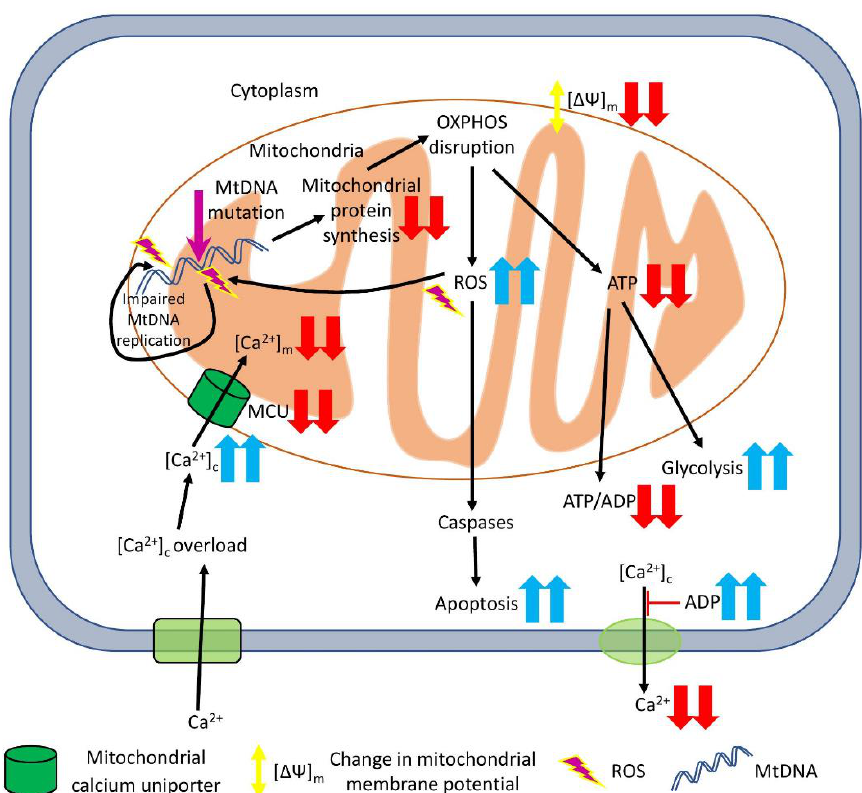
Figure 1. Potential pathways affected by mtDNA mutations and associated with CVD. The mtDNA mutations lead to a decreased level of tRNAs and protein synthesis (including proteins involved in mitochondrial OXPHOS), and increased ROS production and, subsequently, mitochondrial oxidative stress and cell apoptosis. High ROS levels tend to cause more mutations in mtDNA during its replication. OXPHOS malfunction leads to lower ATP output and the collapse of the mitochondrial membrane potential, thus changing the ATP/ADP ratio, interrupting normal ion traffic and stimulating glycolysis as an alternative ATP-generation pathway. An impaired Ca 2+ metabolism can cause the accumulation of Ca 2+ in the cytosol, with low concentrations in mitochondria and extracellular space, which may result in cell swelling and death. Red arrows represent decrease, blue – increase of a particular process/parameter.